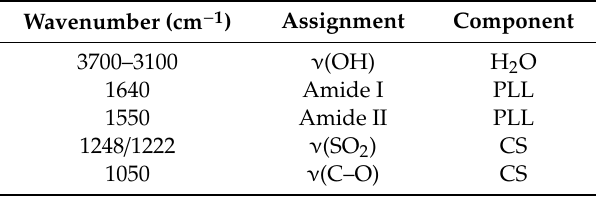
Table 1. Assignment of diagnostic IR bands in ATR ‐ FTIR spectra of PLL/CS PEM films given in Figure 1.